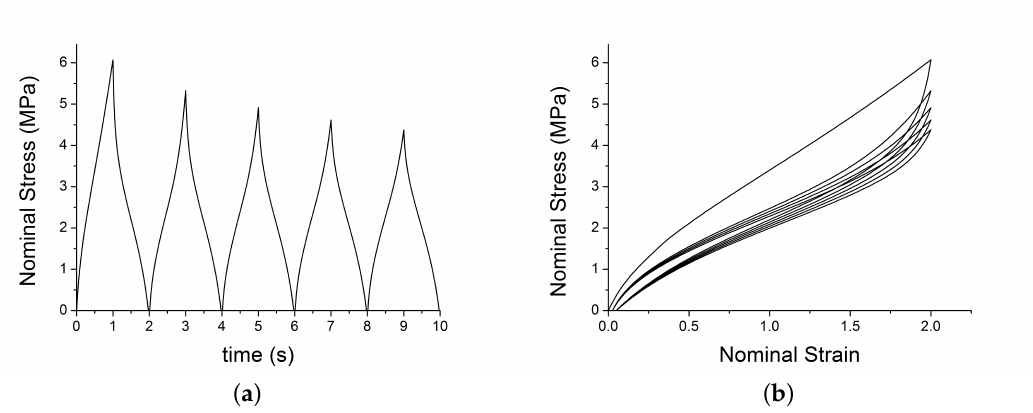
Figure 11. Test 1: VUMAT output: ( a ) shows the nominal stress versus time; ( b ) shows the nominal strain–stress path with the set of parameters in Table